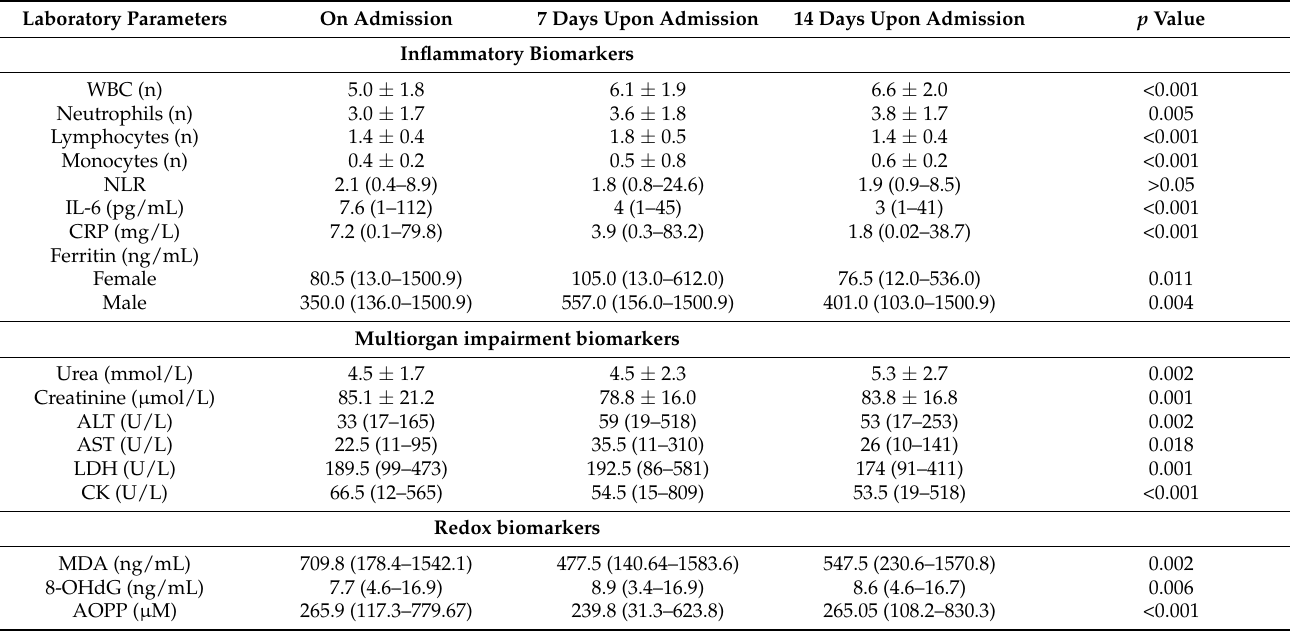
mean± standard deviation. p for ANOVA with repeated measures or Friedman test.